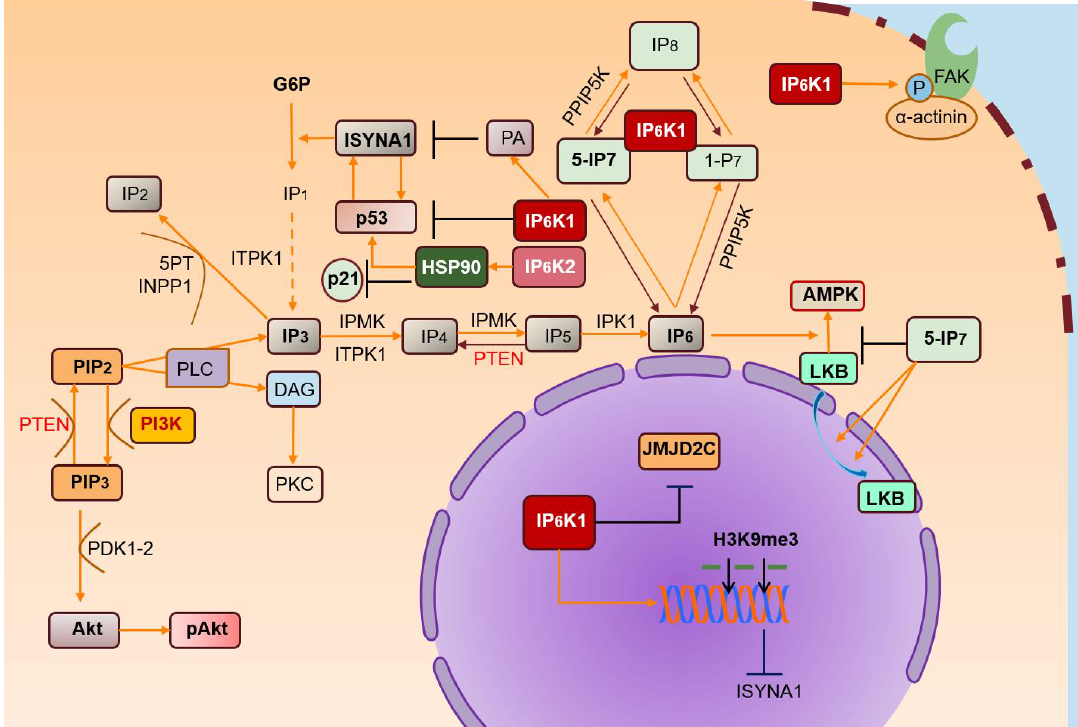
Figure 2. IP 6 Ks and their pathways. IP 3 is metabolized in many inositol polyphosphates, of which IP 6 is the most abundant. IP 6 Ks produce IPs (IP 7 ) starting from IP 6 . IP 6 K / IP 7 levels are crucial for regulating various biological processes. IP 6 K1 binds α -actinin localized at focal adhesions, promoting its phosphorylation by FAK and regulating cell migration. IP 6 -stimulated AMPK activation is inhibited by high levels of IP 7 , reducing cytosolic localization of LKB. High PA levels promote nuclear IP 6 K1 translocation, inhibiting ISYNA1, and consequently, de novo biosynthesis of myo-inositol. Nuclear IP 6 K1 interacts with JMJD2C and induces its dissociation from chromatin, increasing H3K9me3 levels and inhibiting transcription of target genes. Likewise, IP 6 K2 may localize in the nucleus, downstream of its interaction with HSP90. In turn, nuclear IP 6 K2 localization promotes binding to p53, suppressing p21 activation and transcription.